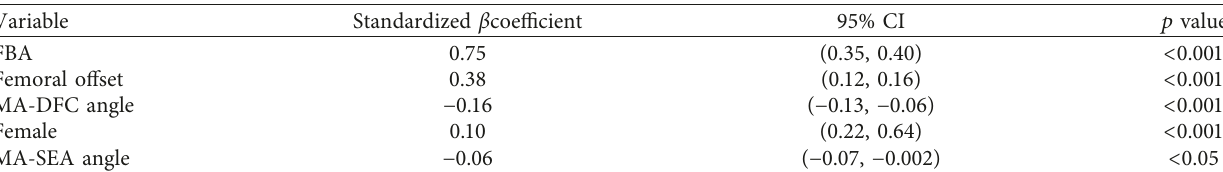
Table 3: Results of linear regression analysis on variables associated with the VCA for the IM